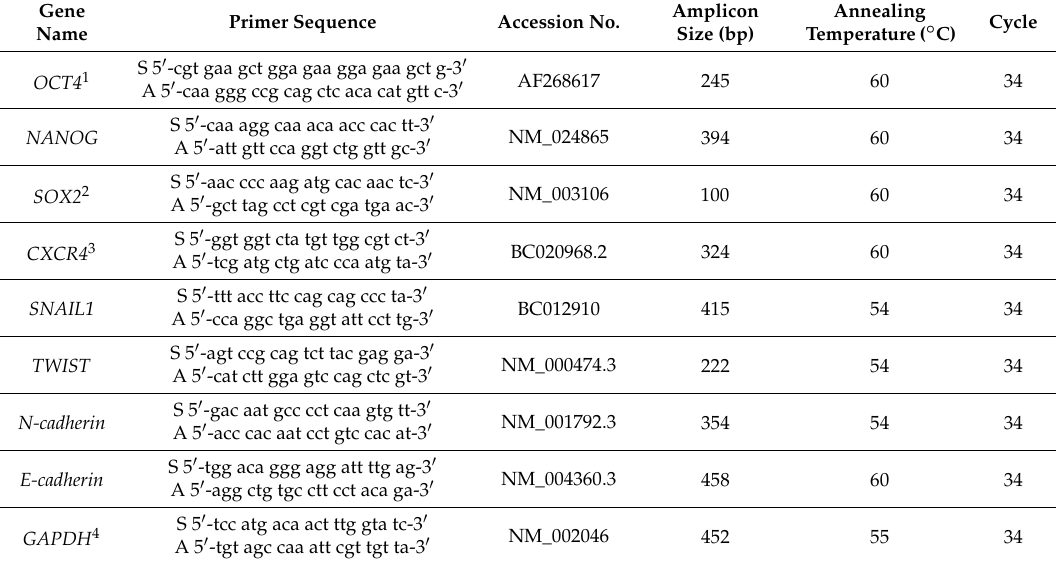
Table 1. Primer sequences for RT-PCR analysis of adipose-derived stem